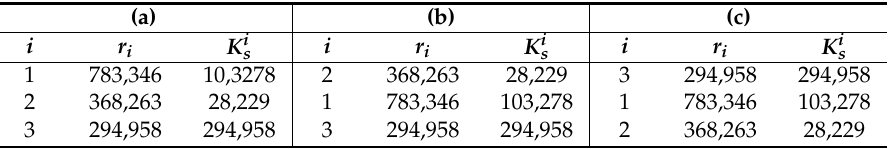
Table 3. RSU1(a), 2(b) and 3(c) key table in round